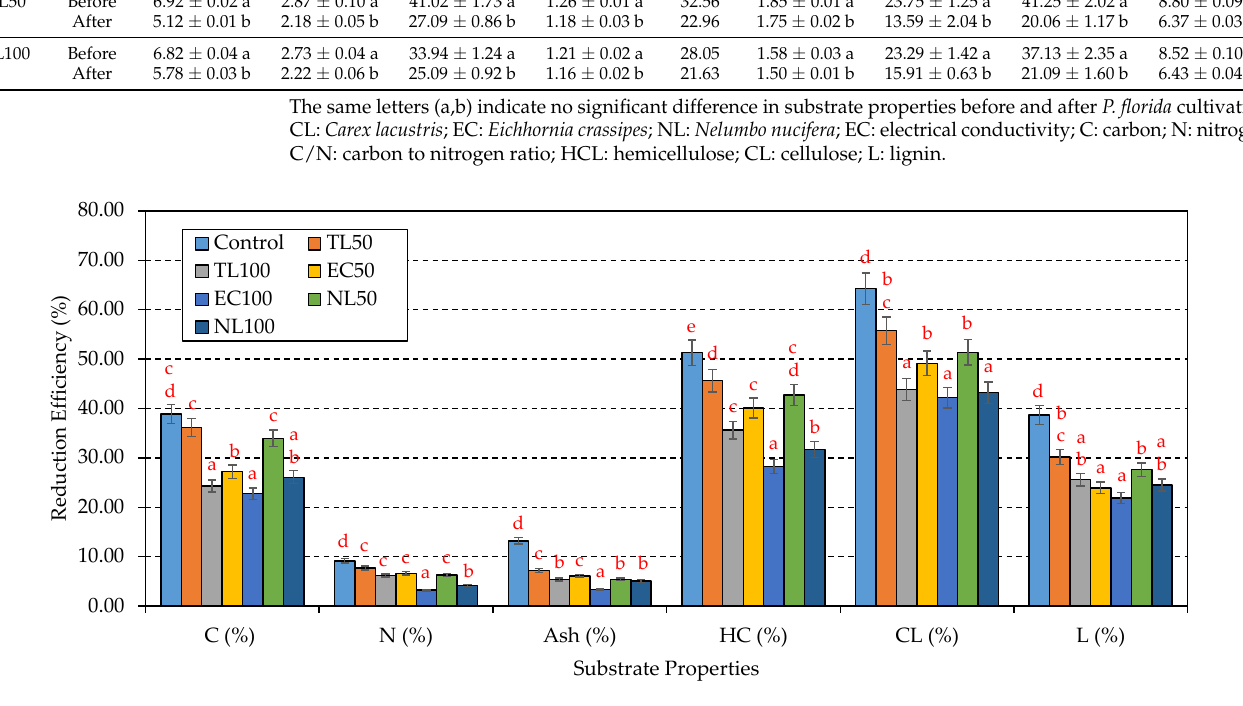
Table 1. Changes in properties (mean ± SD of five replicates) of wetland plant biomass-based sub- strates before and after P. florida cultivation.